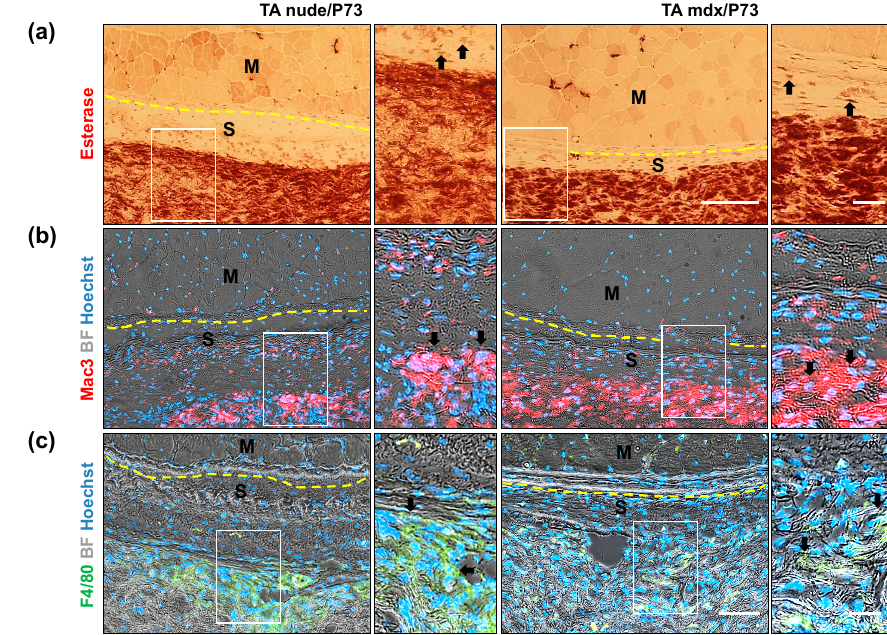
Figure 8. Analysis of inflammatory cells colonisingP73 tissues. Representative images of nonspecific esterase (for macrophages) and immunofluorescence staining of serial muscle sections from P73 tibialis anterior(TA) implanted muscles reveal that the majority of the cells populating scaffolds come from inflammatory origin, as showed by esterase (brown, a ), Mac3 (red, b ) and F4/80 (green, c ) staining performed in nude and mdx muscles. Magnification areas (right panels) show details of staining (black arrows), from rectangles. Dashed yellow lines indicate the borders between muscle and scaffold tissues. Nuclei are stained in blue with Hoechst. Scale bars: left panel a = 100 µm; right panel a = 20 µm; left panel c = 100 µm; right panel c = 20 µm.